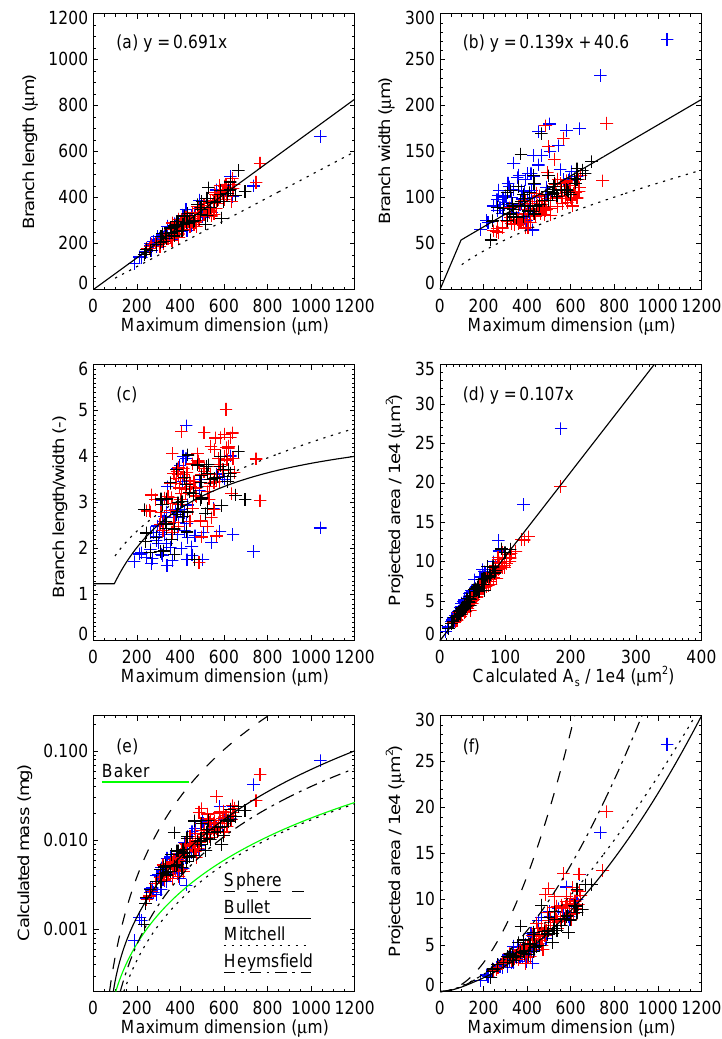
Figure 4. Bullet model: measured and calculated properties of imaged bullet rosettes with six arms (black symbols), fewer than six arms (blue symbols), and more than six arms (red symbols). Line types indicate derived ice properties as follows (see legend in panel e ): a sphere, a six-arm bullet rosette per the bullet model (see Sect. 4.1 and Appendix A1), five-arm rosettes from Mitchell et al. (1996), and cirrus crystals from Heymsfield et al. (2002). Also shown is the habit-independent m − A p relation derived by Baker and Lawson